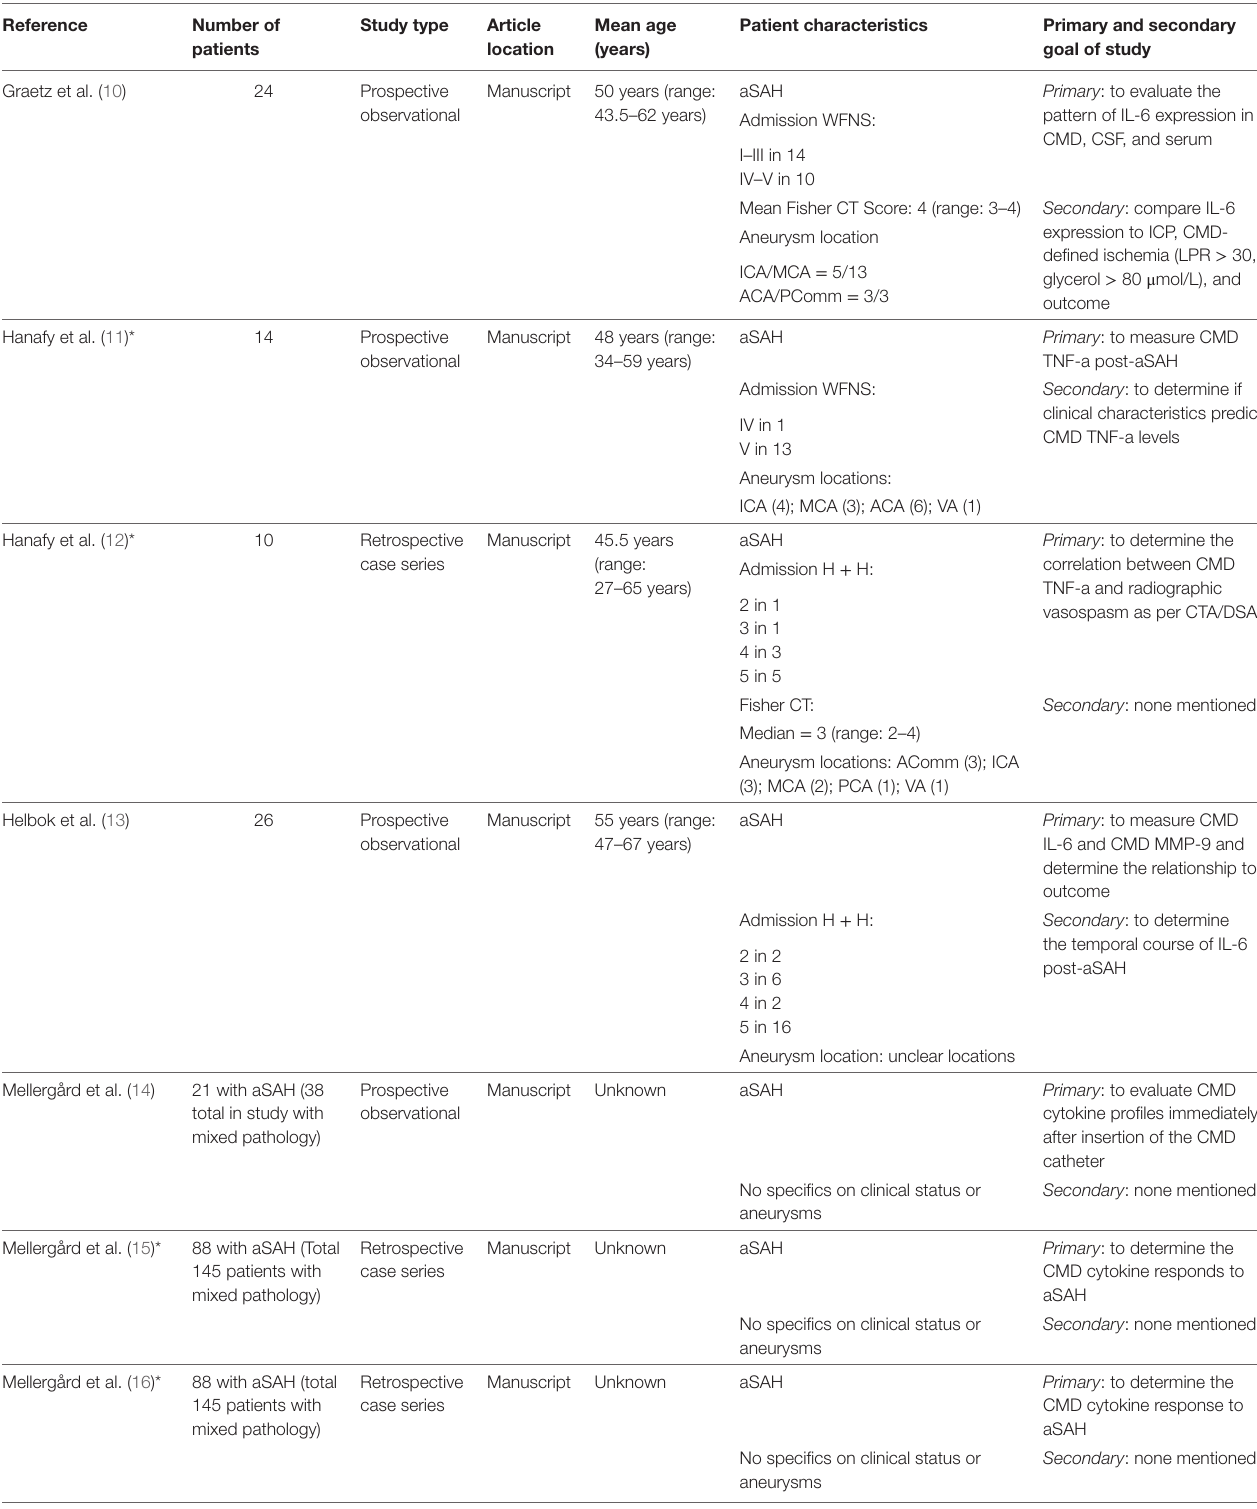
TABLe 1 | CMD cytokine study characteristics and patient